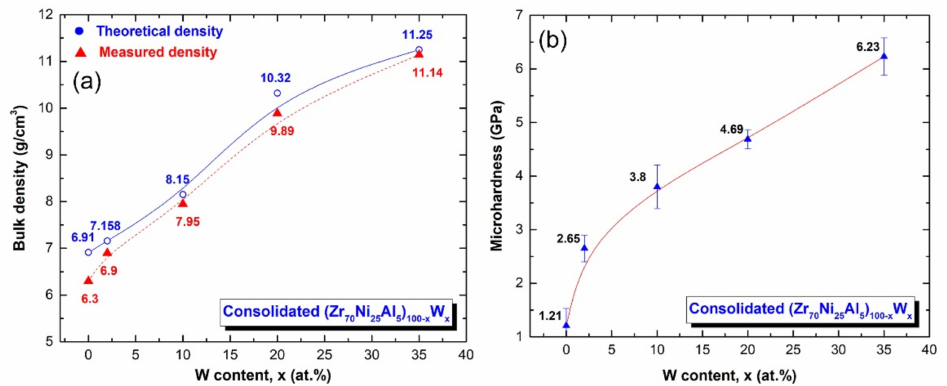
Figure 13. Effect of W (x) concentration on the ( a ) bulk density and ( b ) microhardness of (Zr 70 Ni 25 Al 5 ) 100-x W x metallic glassy